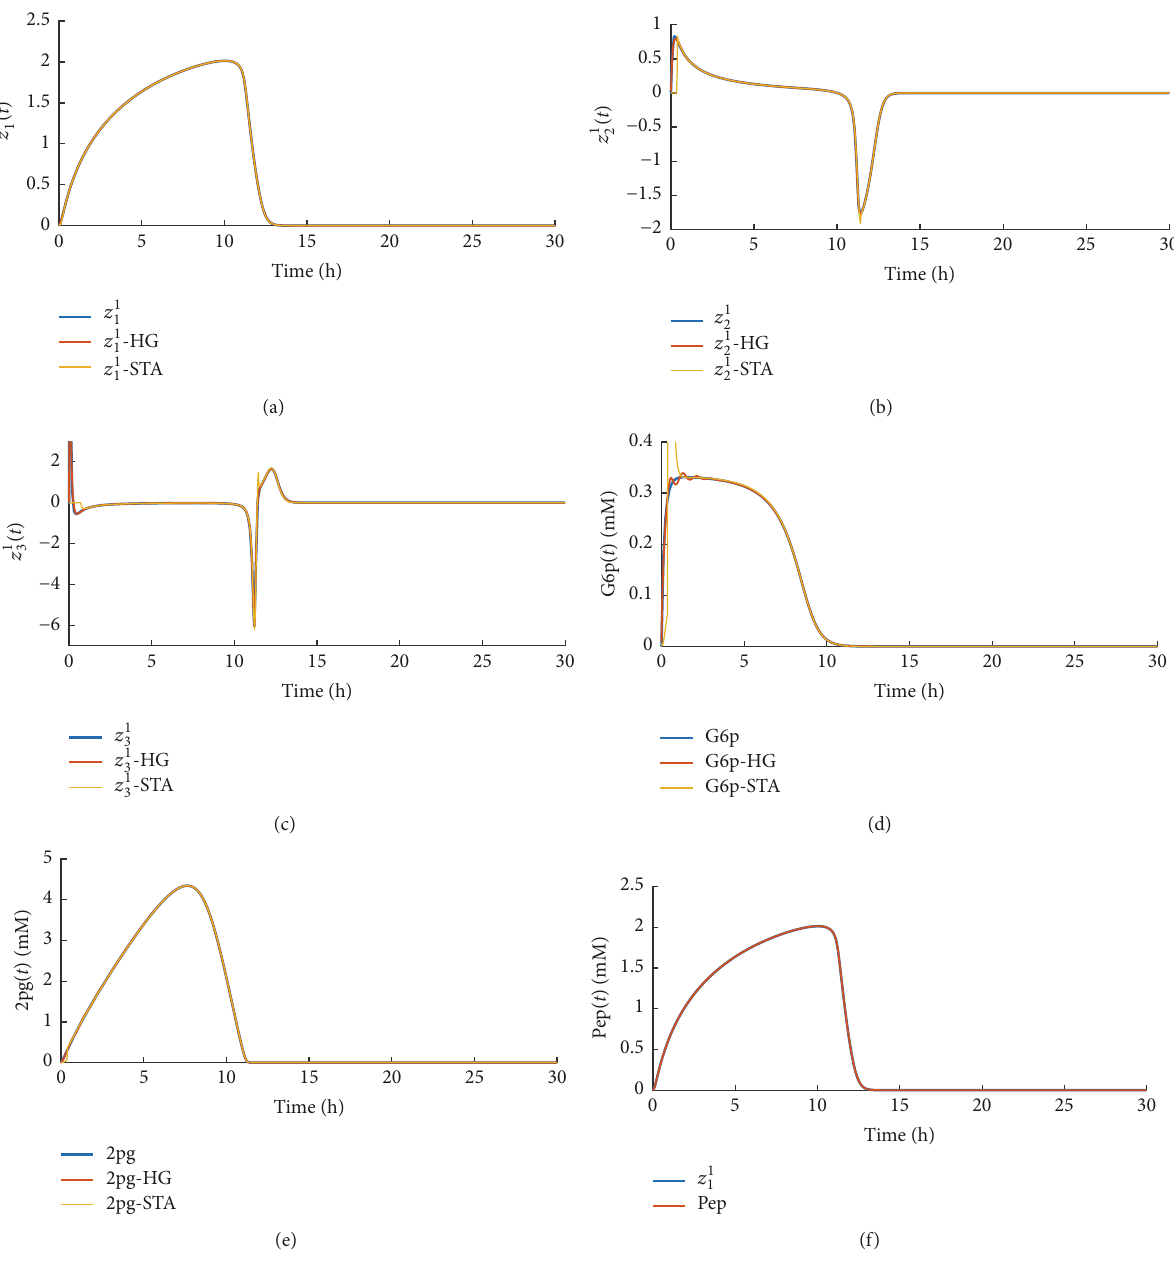
Figure 2: Simultaneous visualization for the states of the transformed coordinates in the first subsystem, the corresponding high-gain observer, and the STA-based estimator: (a) 𝑧 1 1 , (b) 𝑧 1 2 , and (c) 𝑧 1 3 . (d)–(f) depict the variation of the concentrations for the compounds (d) G 6 p, (e) 2 pg, and (f) Pep as well as their estimates produced by the inverse transformation applied to both the high-gain and the STA-based